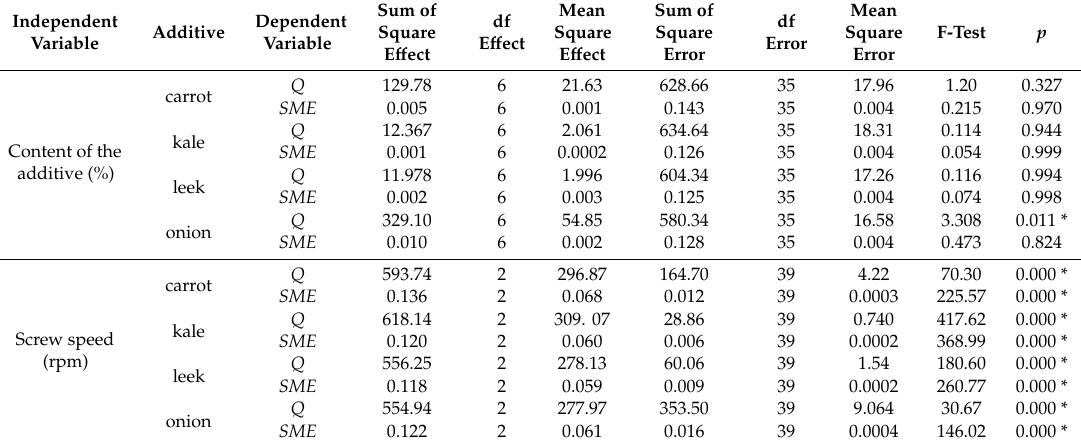
Table 2. Results of analysis of variance of the e ff ects of processing conditions on process e ffi ciency and specific energy consumption during the